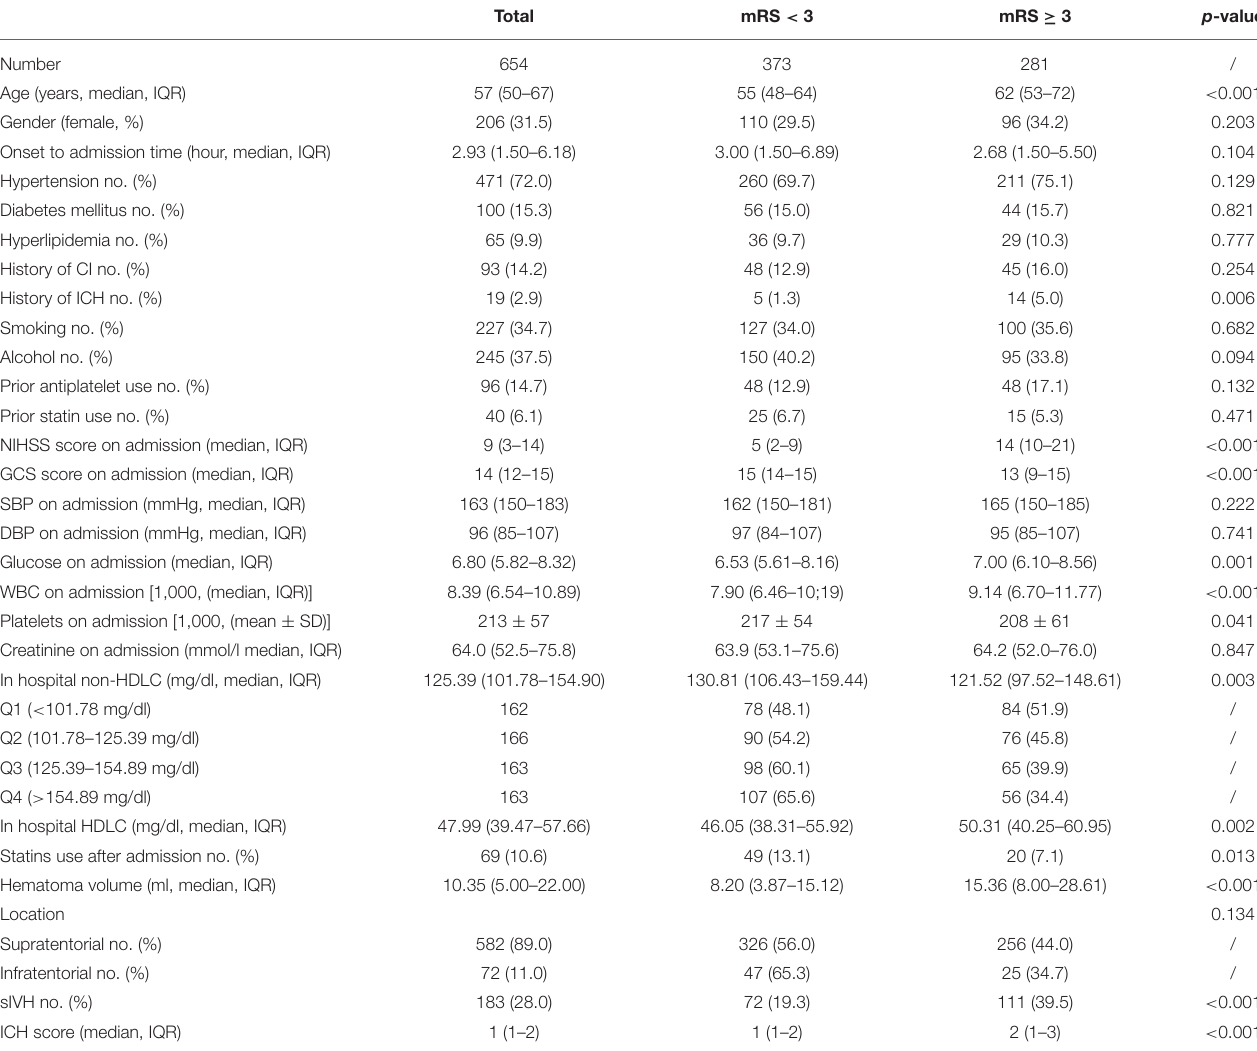
TABLE 1 | Baseline characteristics of the study population according to 90-day clinical outcome.